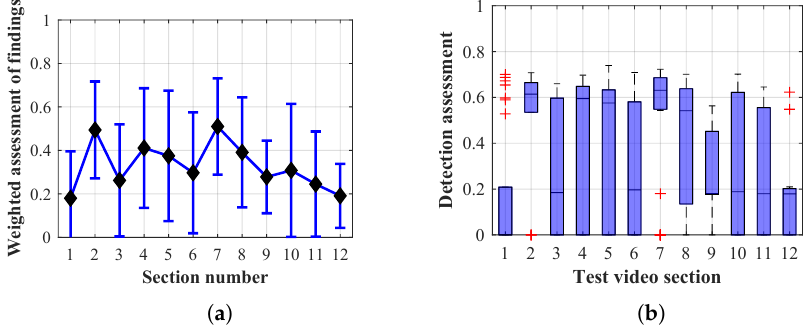
Figure 45. Results of Method 3 with a lifespan of 1 frames. ( a ) the weighted average rating with the average mean absolute error of the weighted rating and ( b ) boxplots of the distribution of the statistical sets of the results of the individual sections evaluated indicating: minimum, 1st quartile, median, 3rd quartile, maximum.